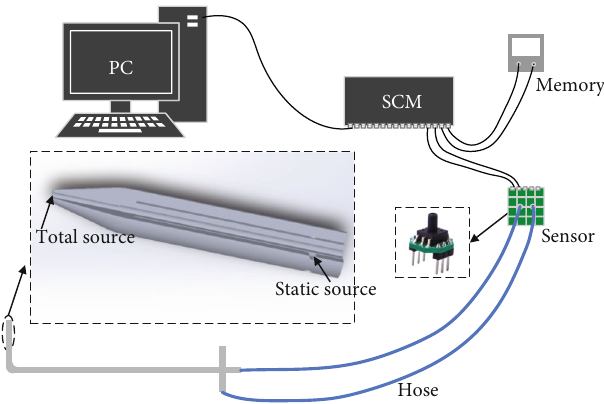
Figure 1: Icing detection system based on the air pressure measurement of the pitot tube.